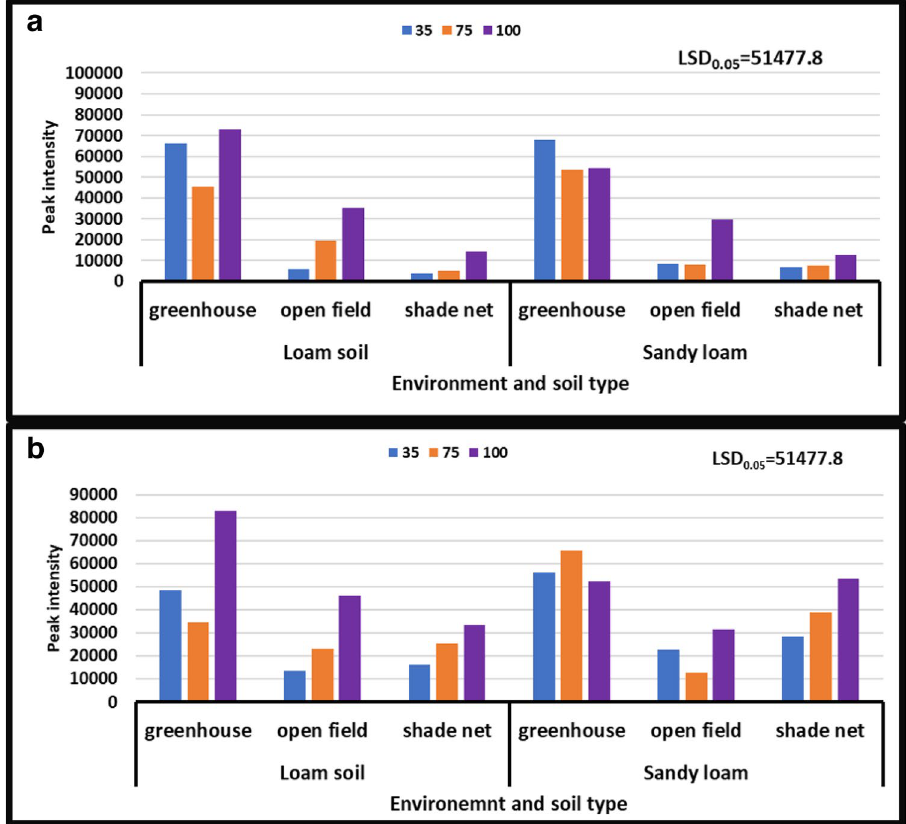
Figure 6. Treatment interaction effect on Acetylcarnitine of African horned cucumber. 35 means severe water stress; 75 means moderate water stress; 100 means no water stress; ( a ) means treatment interaction of water stress levels and soil types at different growing environments during the 2017/18 season one; ( b ) means treatment interaction of irrigation water levels and soil types at different growing environments during the 2018/19 season. Values are average over treatment. Peak intensity showing LCMS-8040 triple quadrupole mass spectrometer intensities which represent the quantity of metabolites varying with treatments. LSD 0.05 is the least significant difference of